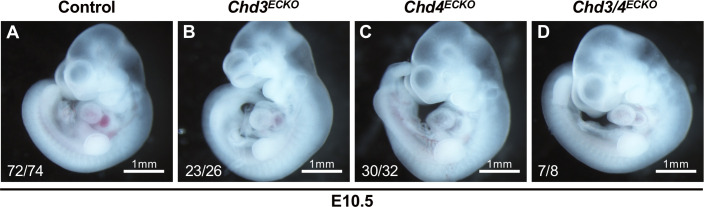
Chd3/4ECKO embryos display normal gross morphology at E10.5.Photographs of representative live E10.5 littermate embryos are shown. Numbers in the bottom left corner of each picture report live embryos/total embryos of each genotype dissected at E10.5. (A): Control = Tie2-Cre- (B): Chd3ECKO
= Chd3fl/fl;Tie2-Cre+ (C): Chd4ECKO
= Chd4fl/fl;Tie2-Cre+ (D): Chd3/4ECKO
= Chd3fl/fl;Chd4fl/fl;Tie2-Cre+.